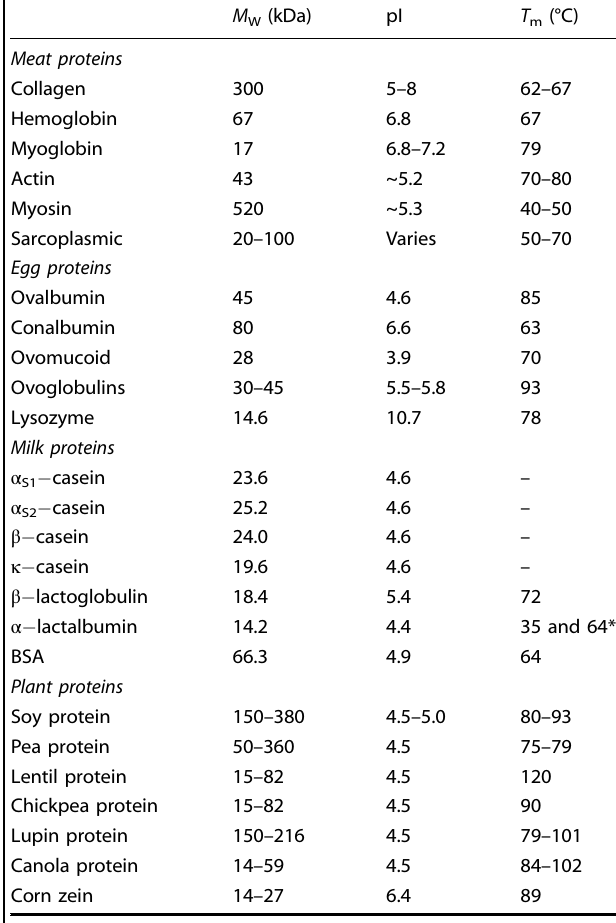
Table 2. Molecular properties of selected plant and animal